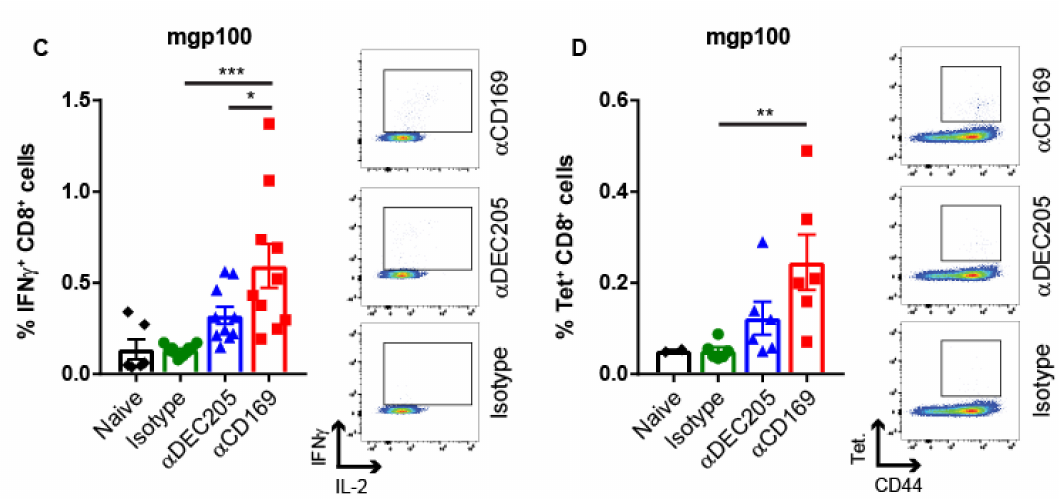
Figure 1. Targeting melanoma Ag to CD169 results in specific T cell responses in mice.